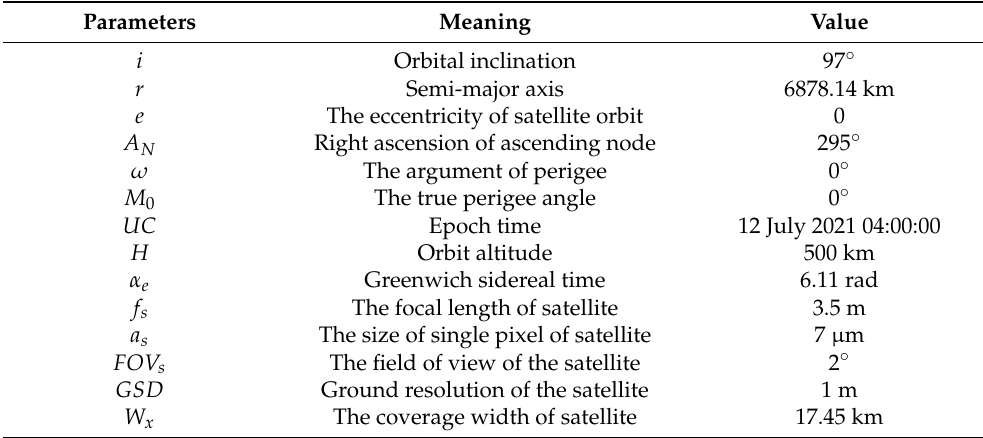
Table 1. Satellite Orbit